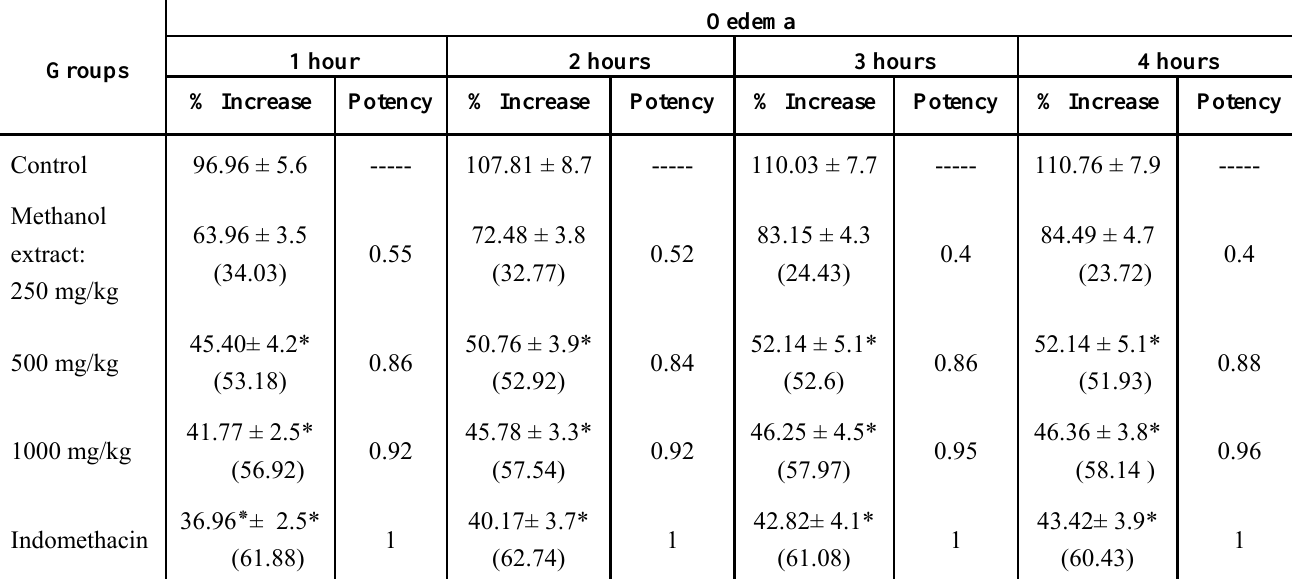
Table 1. Effect of 80 % aqueous methanol extract of O. speciosa aerial parts and indomethacin on carrageenan induced paw oedema in rats